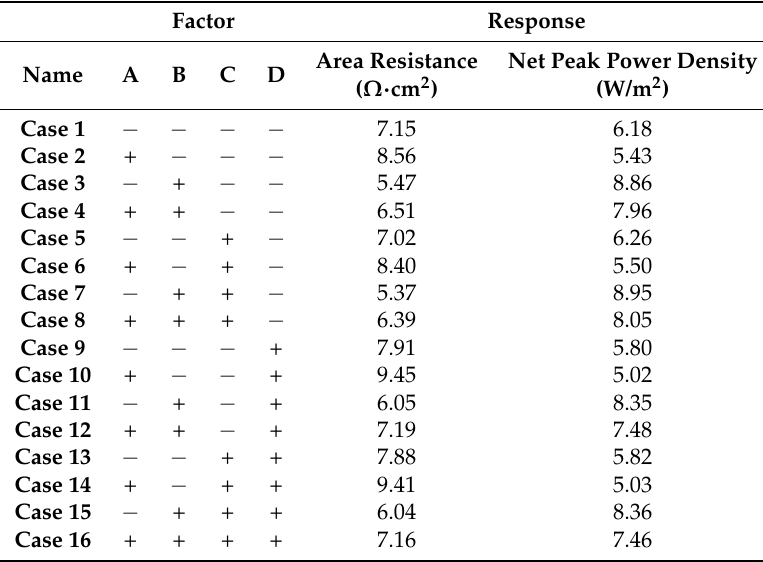
Table 5. Summary of factors, area resistance of the dilute solution compartment, and net peak power densities of the unit cell in the 2D model of a cylindrical corrugated channel: A, velocity; B, temperature; C, corrugation density; D, corrugation height. Case 1 is the base case.